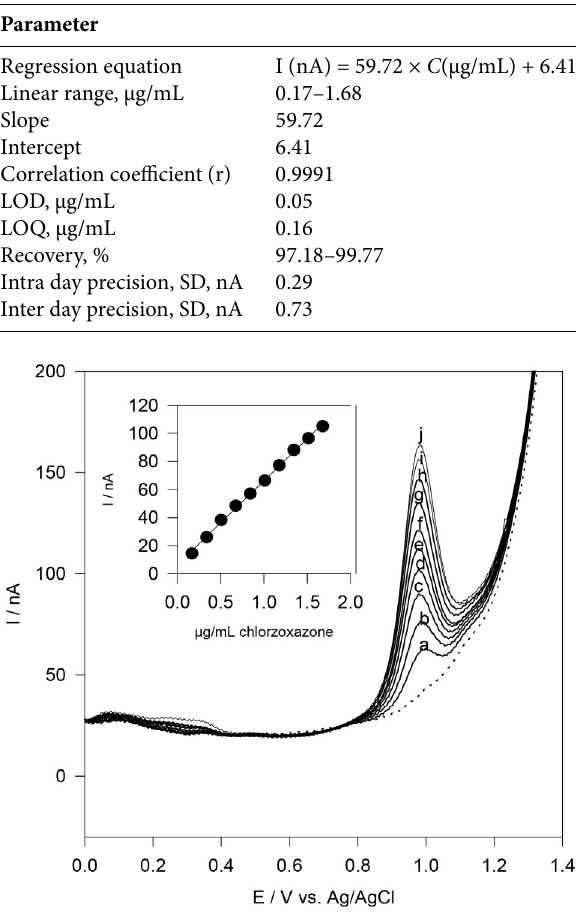
Figure 5. Differential pulse voltammograms for different concentra- tions of chlorzoxazone in 0.04 mol/L Britton–Robinson buffer pH 6.5, scan rate of 50 mV s –1 and pulse amplitude 50 mV: a, 0.169; b, 0.339; c, 0.507; d, 0.676; e, 0.844; f, 1.012; g, 1.179; h, 1.346; i, 1.513 and j, 1.679 μg/ml chlorzoxazone. The dotted line represents the blank solution. Insert: the corresponding calibration plot Table 2. Comparison of linear range and limit of detection for the determination of chlorzoxazone with previously published